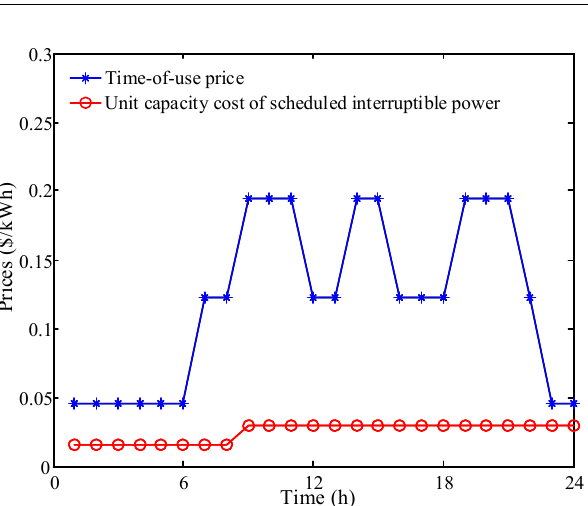
Figure 4. Time-of-use price and unit capacity cost of scheduled interruptible power.